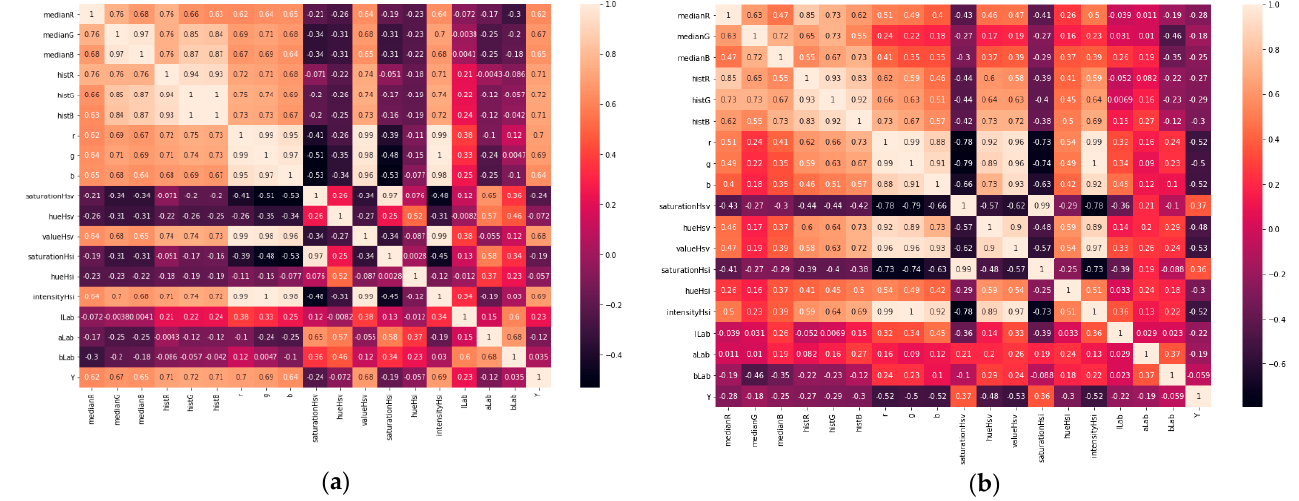
Figure 4. Correlation matrix of extracted features based on colors of ( a ) tuna and ( b ) salmon meat samples .